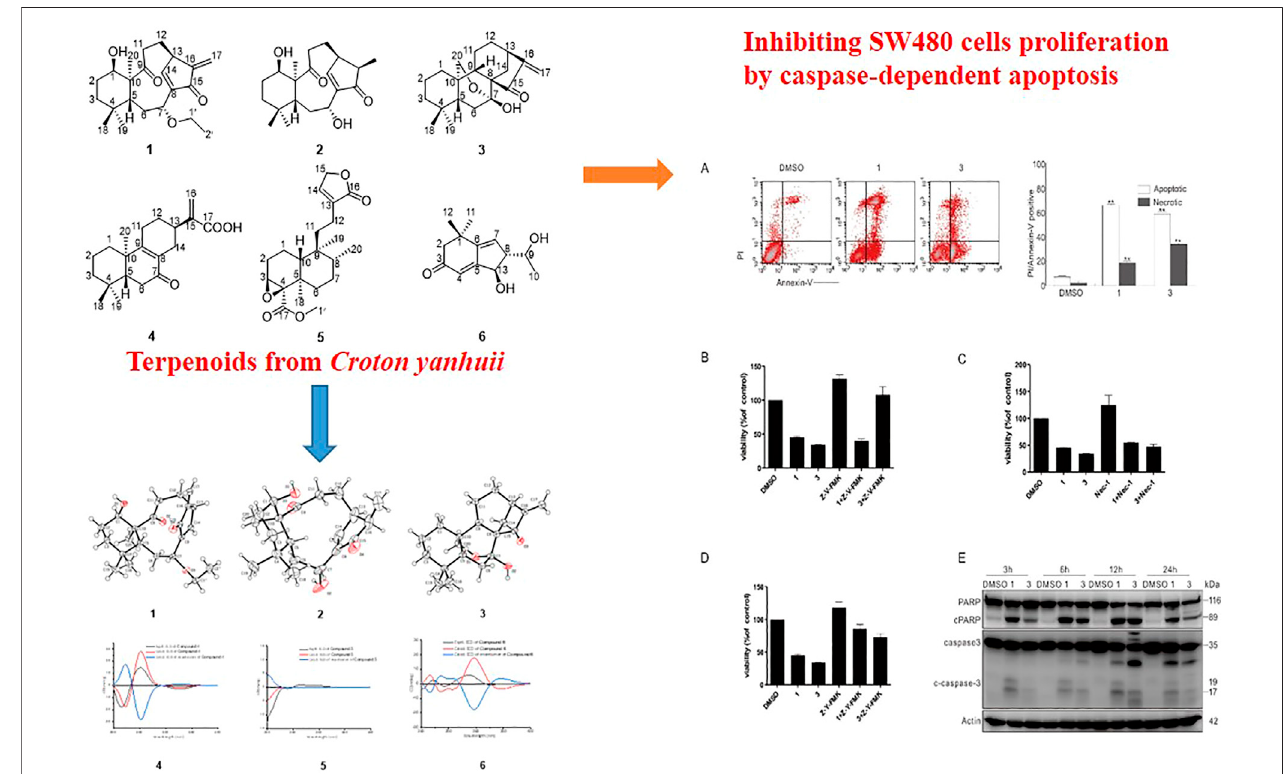
GRAPHICAL ABSTRACT |